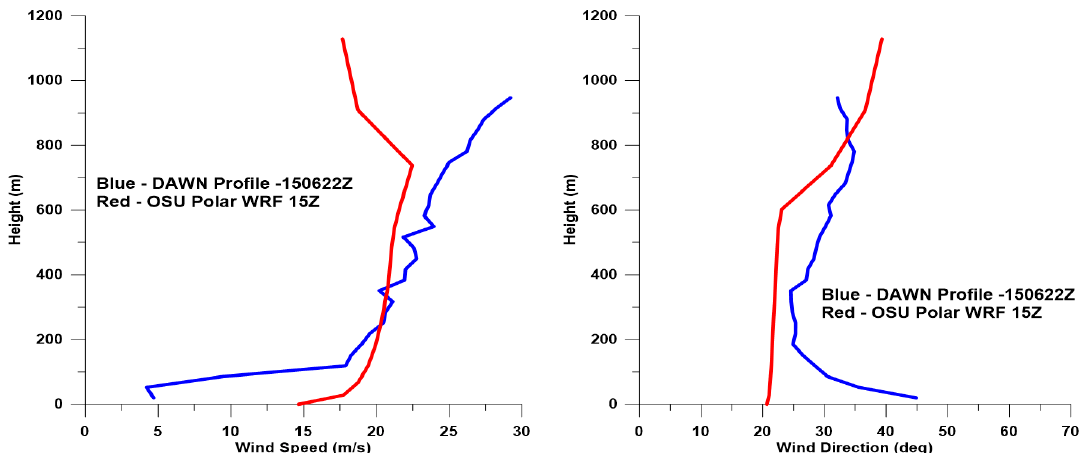
Figure 18. DAWN and model profiles of wind speed ( left ) and wind direction ( right ) near 1506Z on 31 October 2014 for the beginning of leg 1 east of the tip.